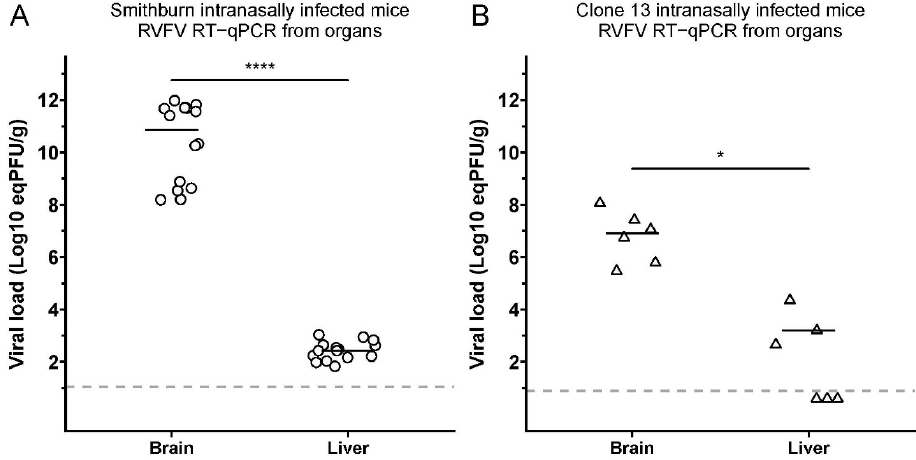
Figure 3. SB and Cl.13 display a higher viral load in the brain than in the liver of IN-infected mice. The graphs report the viral loads (expressed as eqPFU/g) in the brains and livers of euthanized mice intranasally (IN) infected with SB (( A ); n = 15) or Cl.13 (( B ); n = 6). Mice were euthanized when moribund between D5 and D7 p.i. for SB and D6 and D13 p.i. for Cl.13. Negative sera are shown below these lines for each virus at half the value of their detection limits. Statistical analyses were performed using Wilcoxon-Mann–Whitney test (*: p < 0.05; ****: p < 0.0001).